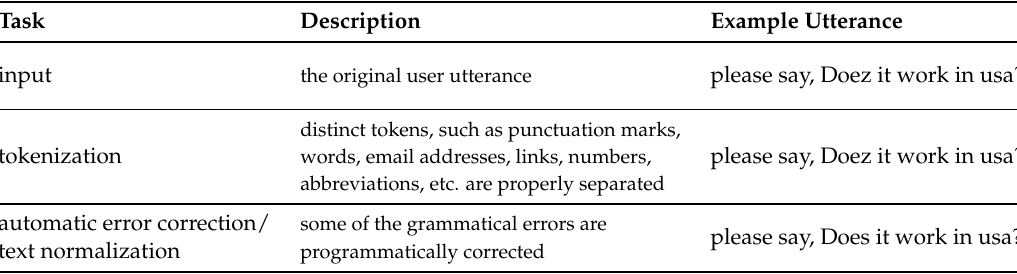
Table 2. An example of